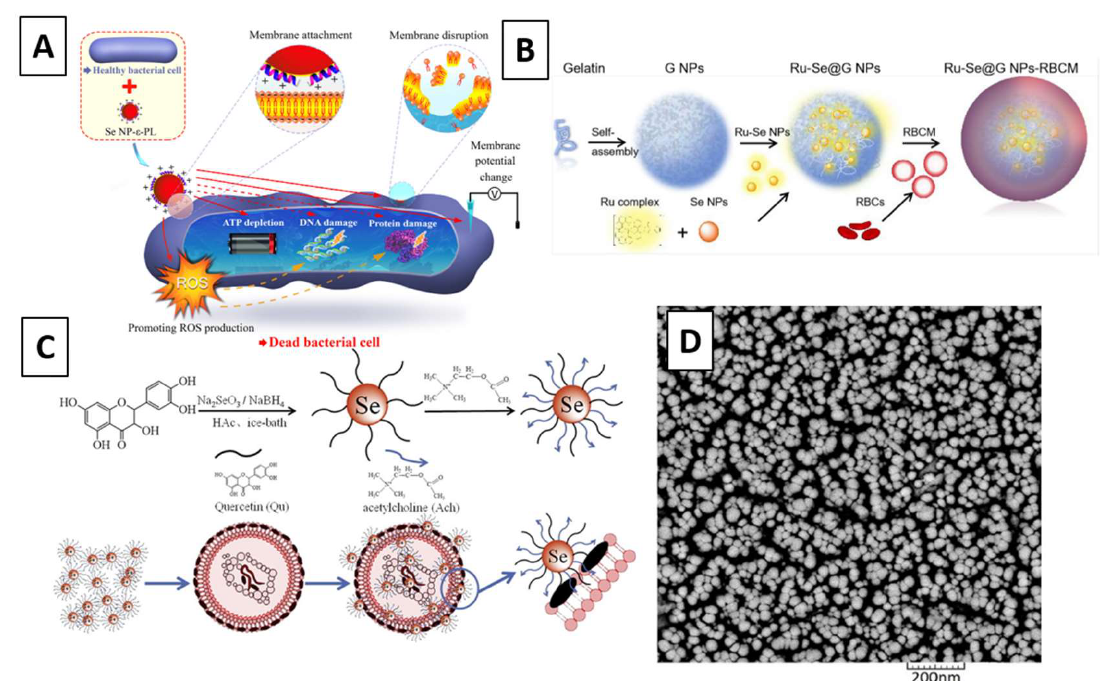
Figure 2. Schematic of the hypothesized antibacterial mechanism of SeNPs can attach to the bacterial cell membrane through electrostatic interactions to damage the bacterial cell by promoting ROS production, depleting ATP, changing membrane potential, and disrupting the membrane (indicated by red solid arrows). ( A ) Se NP- ε -PL has the potential to induce DNA damage and protein damage as well (indicated by red dashed arrows [35]; ( B ) scheme of the synthesis process for Ru-complex-functionalized SeNPs loaded into gelatin NPs [37]; ( C ) synthesis process for a synergistic nanocomposite produced by the conjugating of quercetin (Qu) and acetylcholine (Ach) to the surface of SeNPs [39]; ( D ) scanning electron microscopy (SEM) images of chemically synthesized SeNPs [41]. Reprinted with permission.